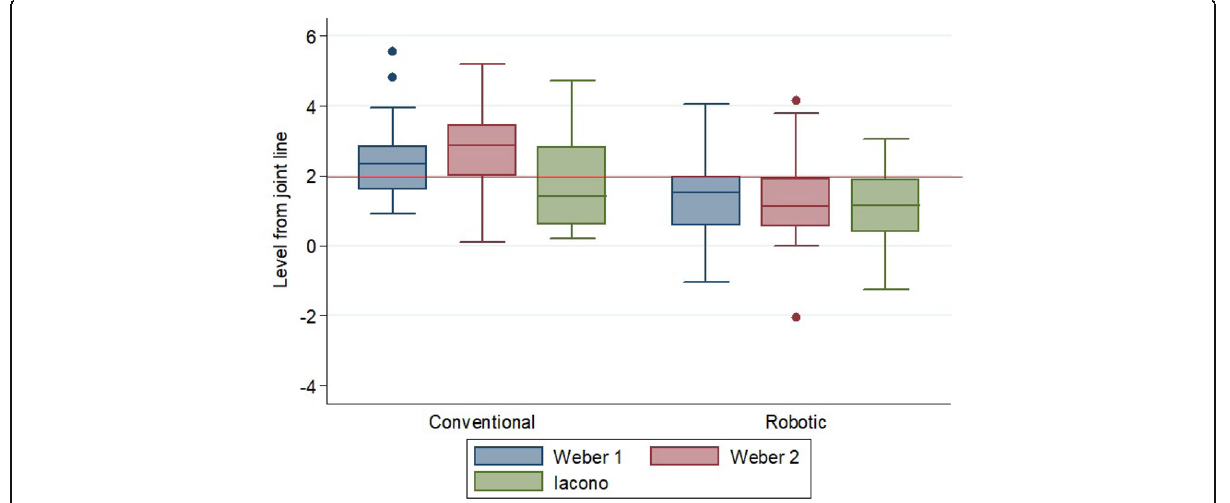
Fig. 4 The distribution of the position of the femoral component compared to the femoral joint line. Three methods were used to differentiate between the robotic-assisted and conventional groups